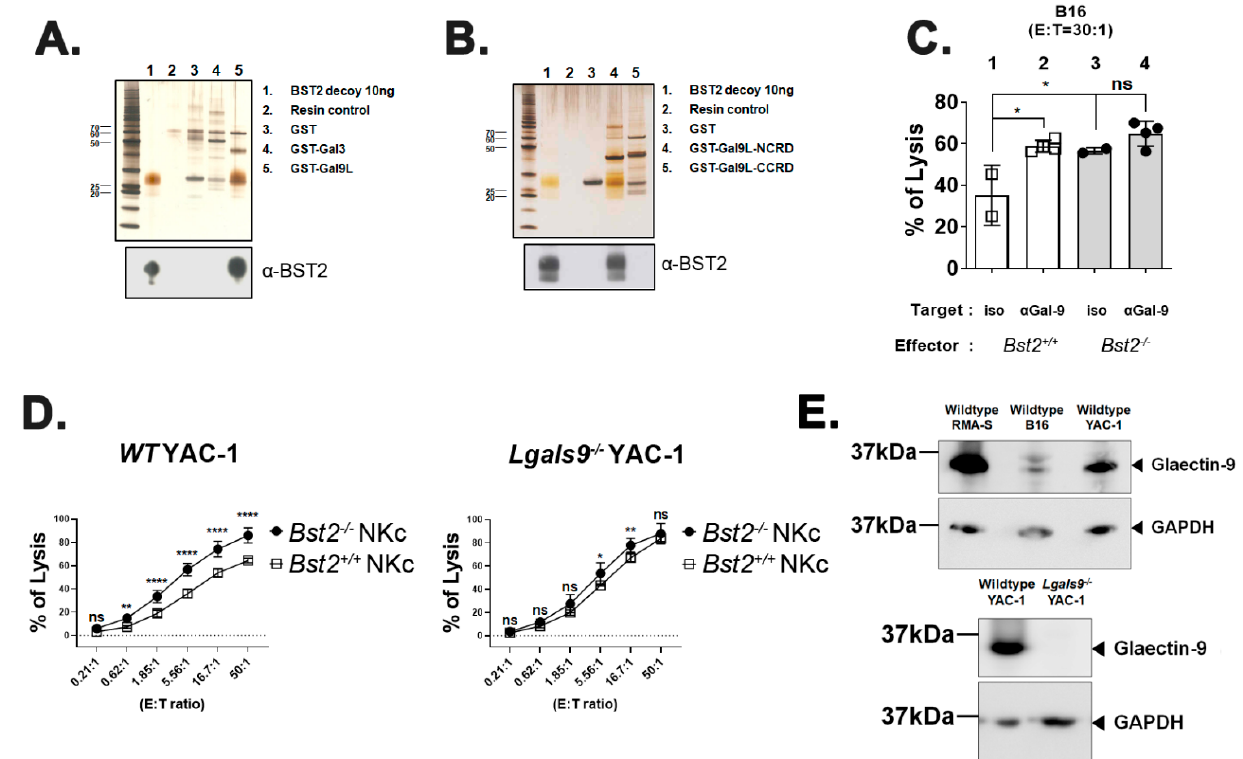
Figure 3. Galectin-9 is associated with BST2-dependent NK cell activity. ( A ) Recombinant BST2 protein was pulled down with GST-tagged Gal-3 (GST-Gal3), as well as the GST-tagged long isoform of Gal-9 (GST-Gal9L). Precipitates were then analyzed by western blotting with anti-BST-2 antibody. ( B ) Recombinant BST2 protein was pulled down with either GST-tagged NCRD or CCRD of Gal9L (GST-Gal9L-NCRD or GST-Gal9L-CCRD). Precipitates were then analyzed by western blotting with anti-BST-2 antibody. ( C ) Naïve splenocytes of B6-origin Bst2 +/+ and Bst2 -/- mice were stimulated by IL-2 for seven days to generate LAK cells. CFSE stained Bst2 +/+ and Bst2 -/- LAK cells were co- cultured with target cells (B16) for 4 hrs at 37 ◦ C in a humidified incubator in the presence of isotype control antibody or anti-Gal-9 antibody. Cells were stained with 7-AAD after cultivation. These cells were then fixed with 1% paraformaldehyde and analyzed by flow cytometry. CFSE - , 7-AAD + population is designated as lysed target cells. Graphs showed a mean ± S.D. ( n = 2–4 per group). ( D ) Naïve splenocytes of B6-origin Bst2 +/+ and Bst2 -/- mice were stimulated by IL-2 for seven days to generate LAK cells. Calcein-AM stained target cells (Wild type (WT) YAC-1 and Lgals9 -/-